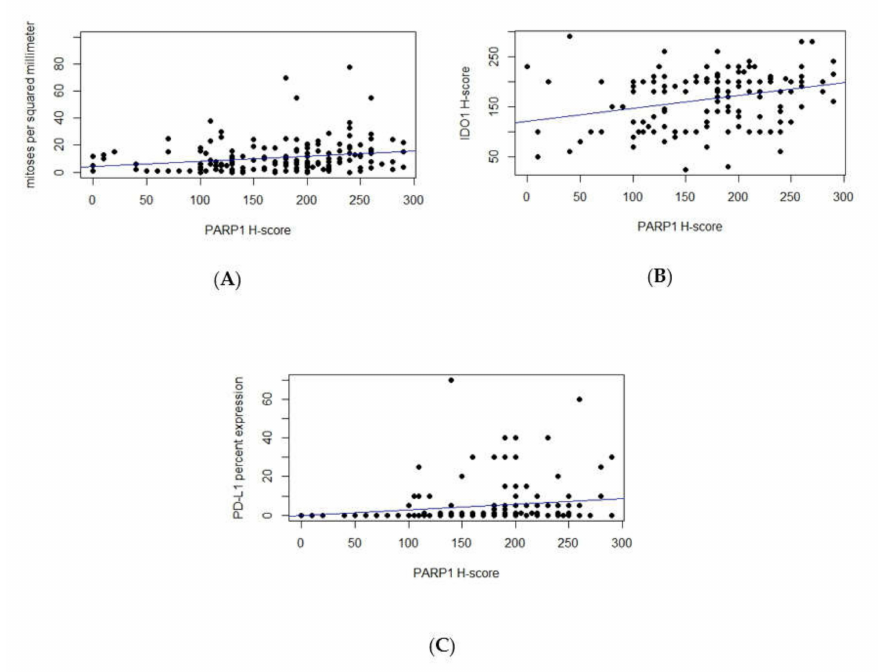
Figure 3. Using linear regression analyses, correlations were observed between PARP1 H-scores and mitotic index ( p = 0.0052) ( A ), IDO1 H-scores ( p = 0.0001) ( B ), and PD-L1 percent expression ( p = 0.04) ( C